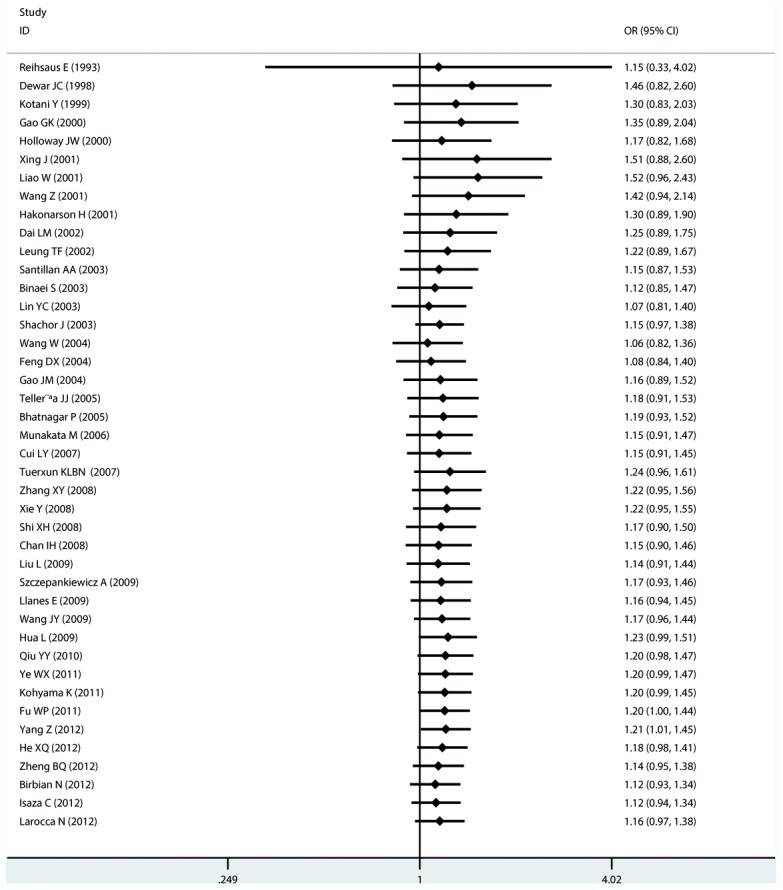
Forest plots of cumulative meta-analysis of Arg16Gly (rs1042713) in association with asthma by published year under homozygote genotype comparison.